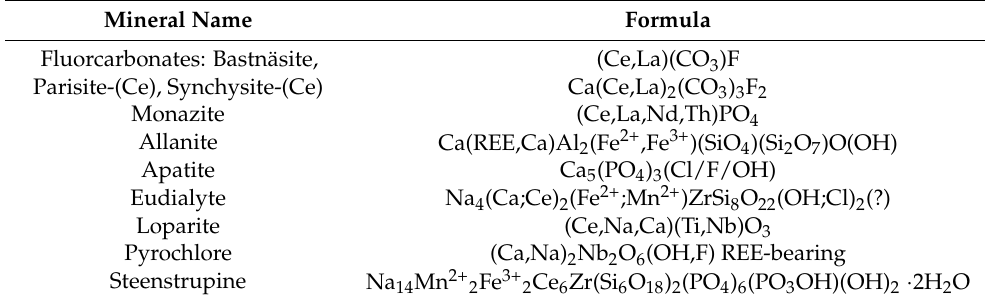
Table 1. A selection of the most common REE-bearing minerals found in carbonatite and alkaline igneous